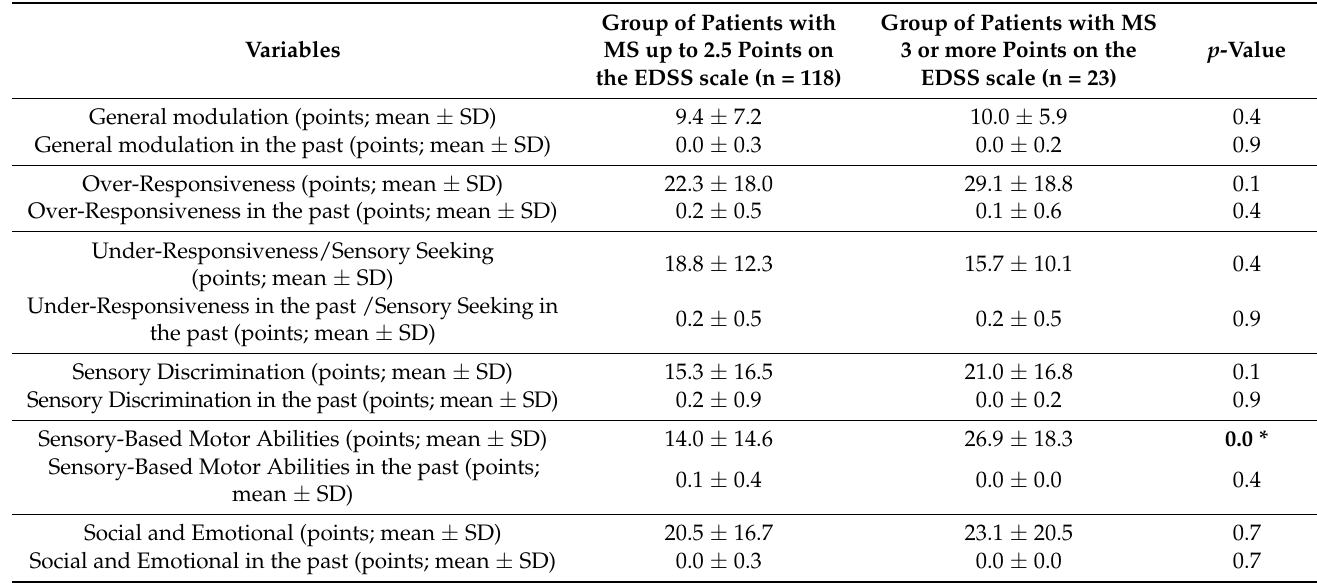
Table 3. The differences in the severity of sensory integration disorders between MS patients con- cerning the stage of the disease using the EDSS